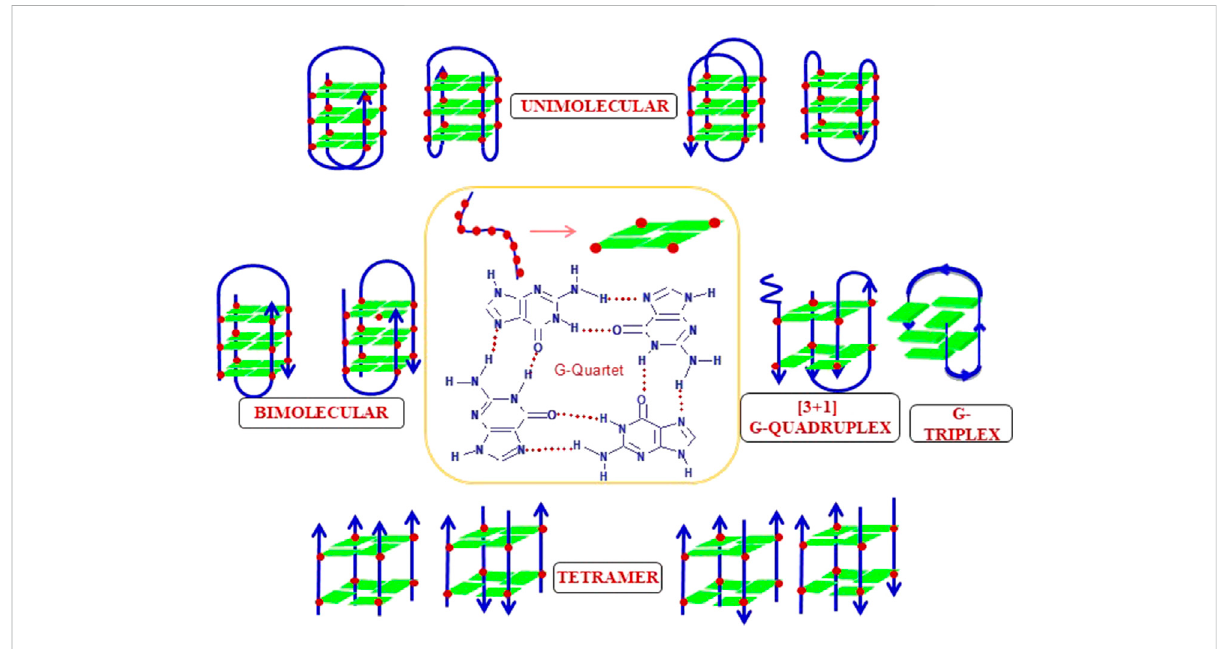
FIGURE 12 Different topologies adopted by a G-quadruplex